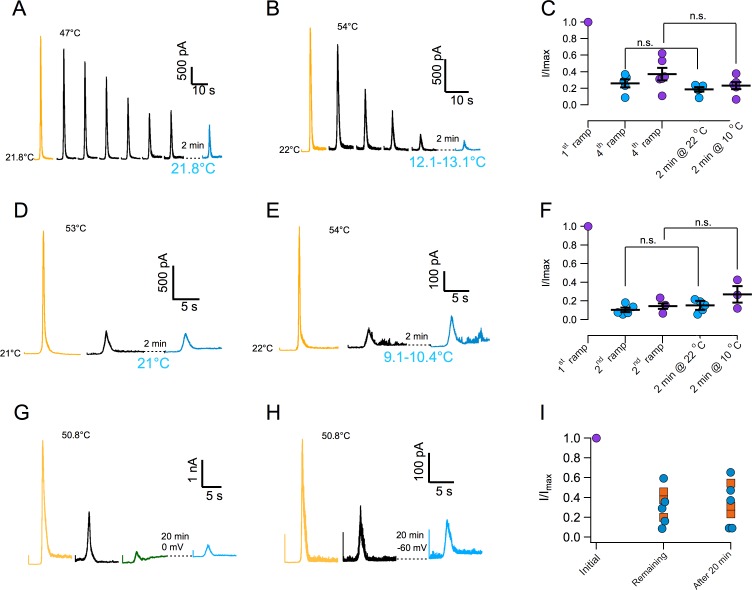
Inactivation of TRPV1 by multiple temperature ramps is irreversible.(A) In this particular patch, seven consecutive ramps to the temperature indicated were applied with an interval of 30 s to produce ~60% inactivation. The patch was left at the bath temperature (21.8°C) for a 2 min recovery period, after which another identical activation ramp did not elicit a current larger than the residual current after inactivation, indicating absence of recovery from inactivation. (B) Another patch was subjected to five activation ramps that produced ~80% inactivation. This time, during the 2 min recovery period, bath temperature was lowered to between 12 and 13°C. Again, no current was produced by an activation ramp, indicating no recovery. Maximal temperature during the ramp is indicated in each panel. (C) Summary of results from several experiments indicating no recovery of current after a 2 min period at normal bath temperature (~22°C, blue circles) or in a cooled bath (10°C, purple circles). Statistical difference was tested with a Student-t test, n.s. indicates no difference (p>0.2). (D) Similar to (A) but in this patch the current was elicited by a ramp to a larger temperature, indicated in each panel, which produced a larger inactivation in a single ramp (80%). After a 2 min period at 21°C, no current was recovered. (E) Same as in (C) but with a recovery period at 10°C. No recovery of current is evident. (F) Summary of results from several experiments as in (D) and (E) indicating no recovery of current after a 2 min period at normal bath temperature (~22°C, blue circles) or in a cooled bath (10°C, purple circles). Absence of significant recovery was based on a Student t-test with p>0.2. The label n.s. indicates non-significance. (G) No recovery of current is observed with a longer recovery period of 20 min at 0 mV or at −60 mV (H). (I) Summary of recovery of five patches held at 0 mV for 20 min after current inactivation (blue circles) and three patches held at −60 mV for 20 min after current inactivation (orange squares). No current is recovered, regardless of the fraction of inactivated current.10.7554/eLife.36372.011Figure 3—source data 1.Raw data for Figures 3C, 3F and 3I.